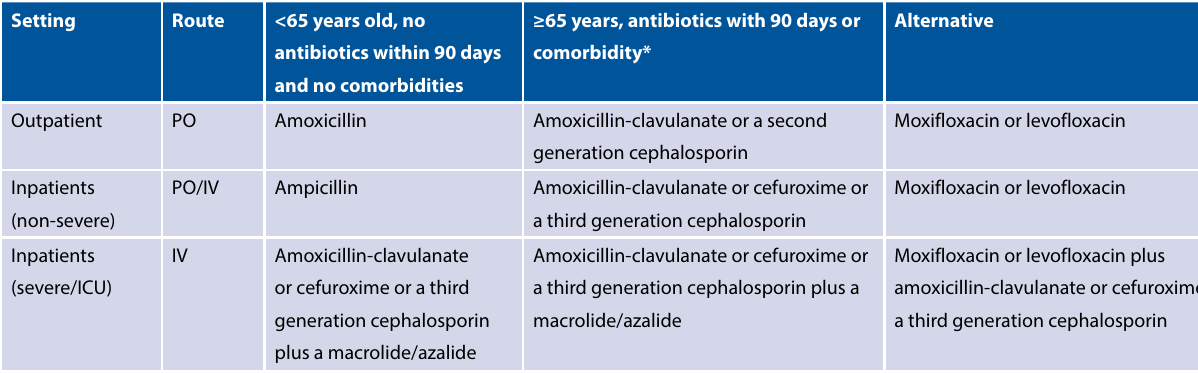
Table 1: Empiric choice of antibiotics for CAP